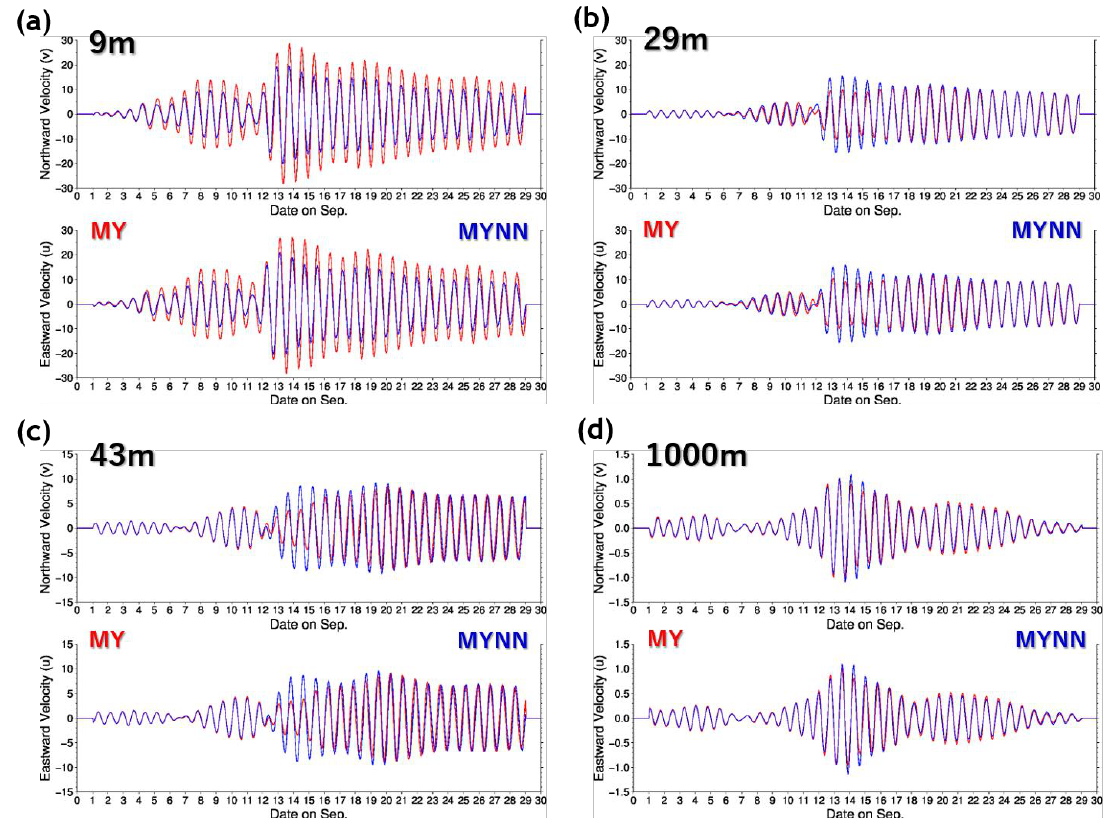
Figure 8. Time evolutions of the band-pass-filtered velocity simulated by the Mellor–Yamada (MY) (solid red line) and the Mellor–Yamada–Nakanishi–Niino (MYNN) (solid blue line) models at depths of ( a ) 9, ( b ) 29, ( c ) 43, and ( d ) 1000 m at a point of 133 ◦ 40.7 (cid:48) E, 38 ◦ 40.0 (cid:48) N (denoted by the red star in Figures 1 and 2). The top row in each panel is the meridional velocity, and the bottom row in each panel is the zonal